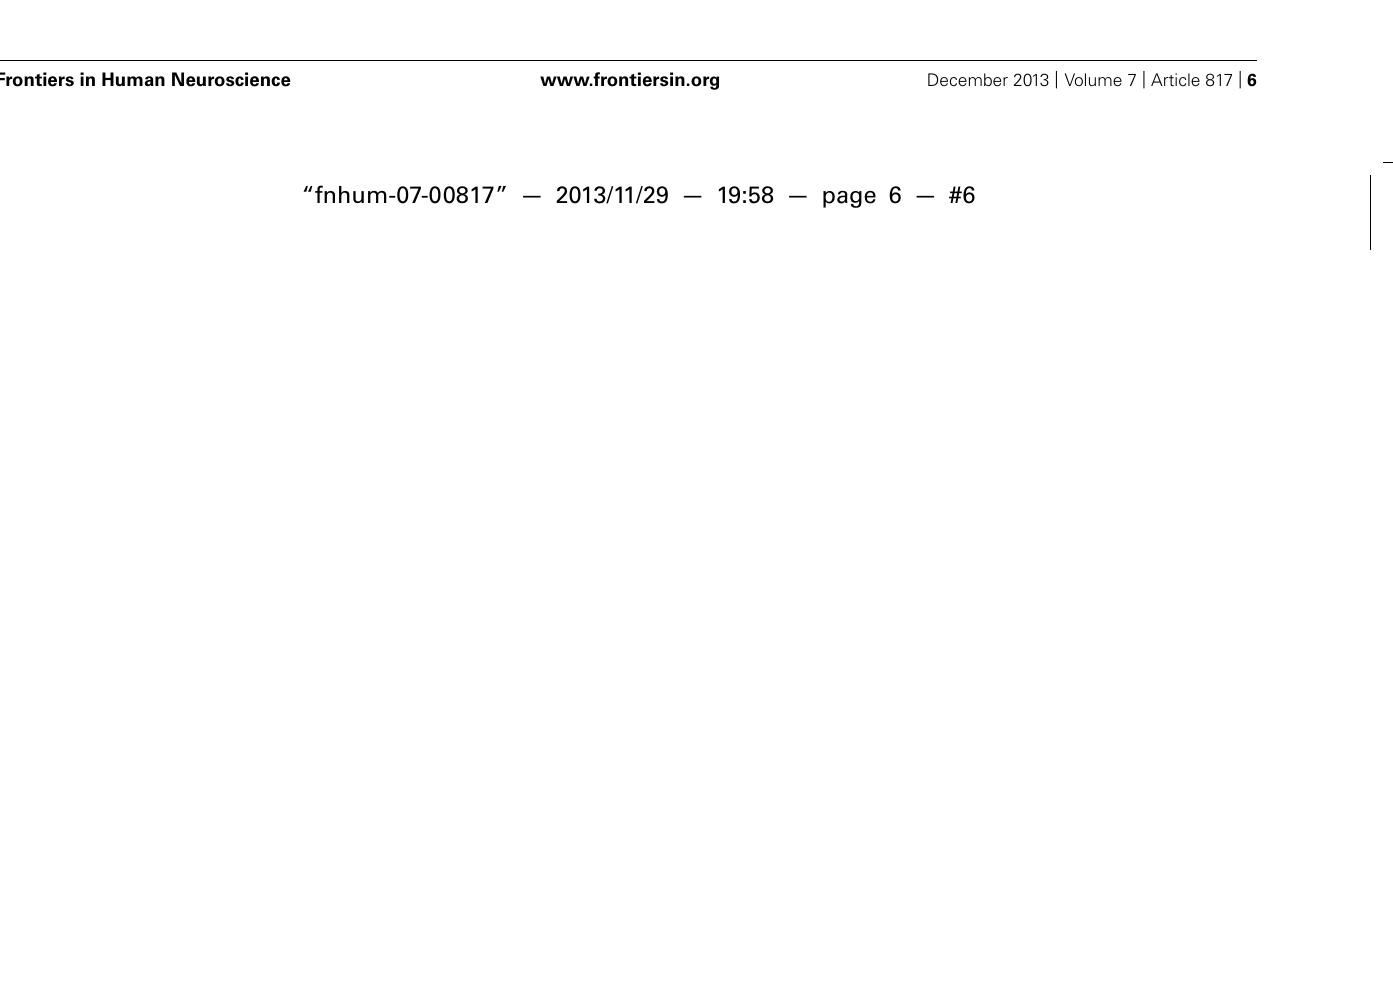
(31, − 58, 16), superior longitudinal fasciculus (B) MNI-coordinate (31, − 24, 34), and at positions that correspond with the optic radiations. The results show that the majority of the tactile activation is found in the contralateral tracts connecting the thalamus and sensory cortex. Maximum cumulative values are found at MNI-coordinates ( − 27, − 30, 34; C ) and ( − 19, − 22, − 3; D